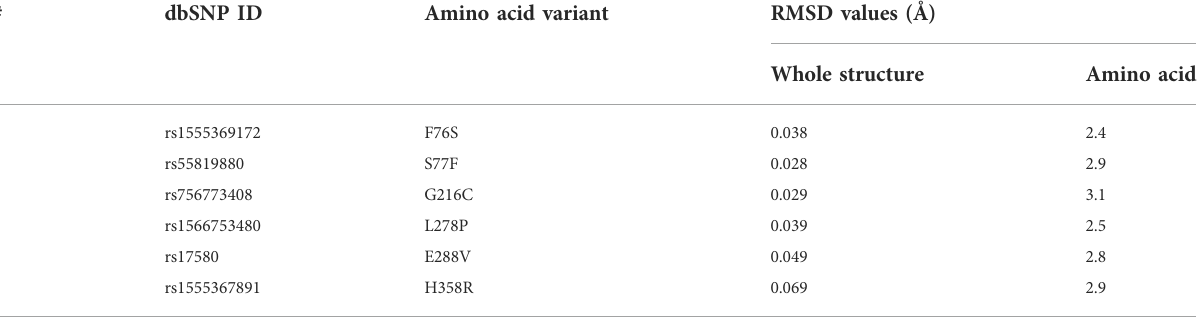
TABLE 3 3D structural deviation of mutated A1AT protein structures versus wildtype represented in the form of RMSD